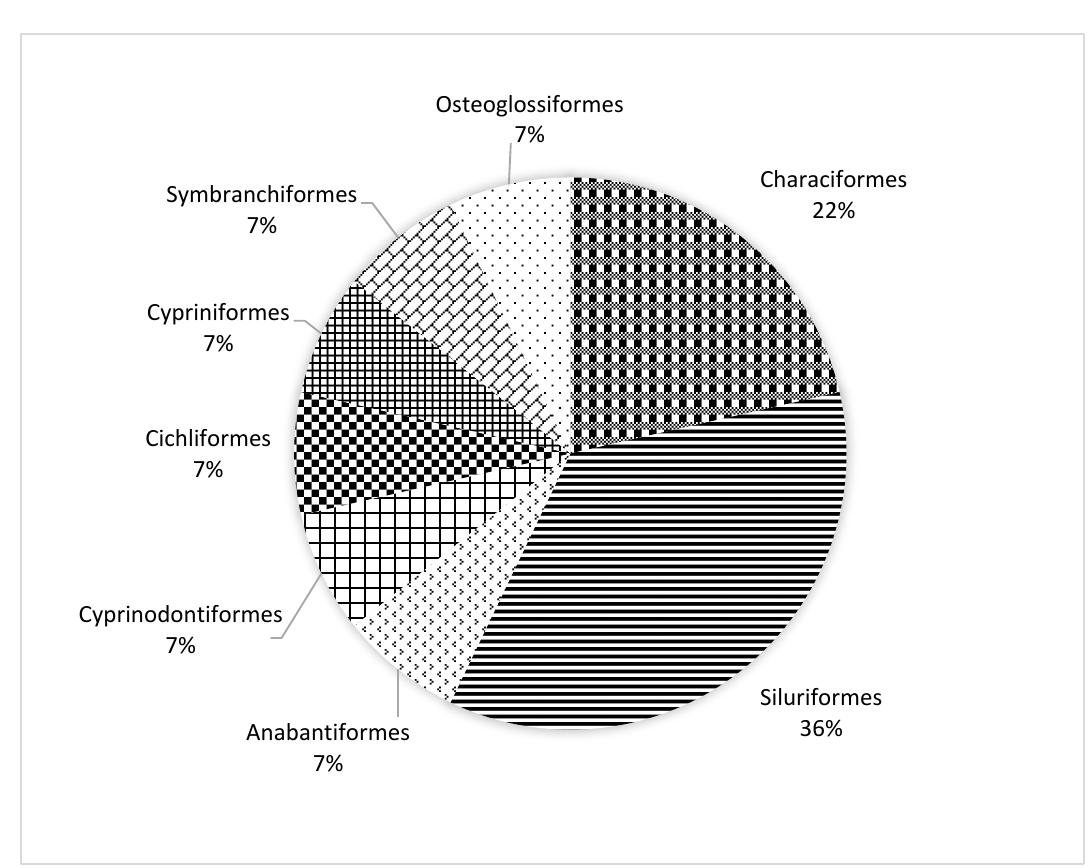
Figure 2. Percentage abundance of the different orders of fish sampled in the overall study area.